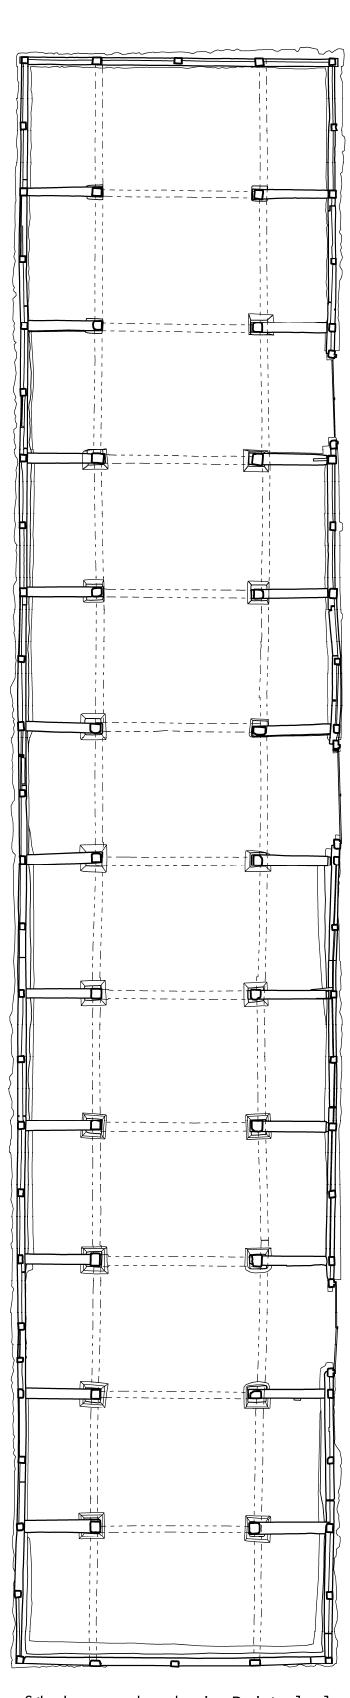
Fig. 2 Plan of the barn produced using Pointools plug-in for Auto-